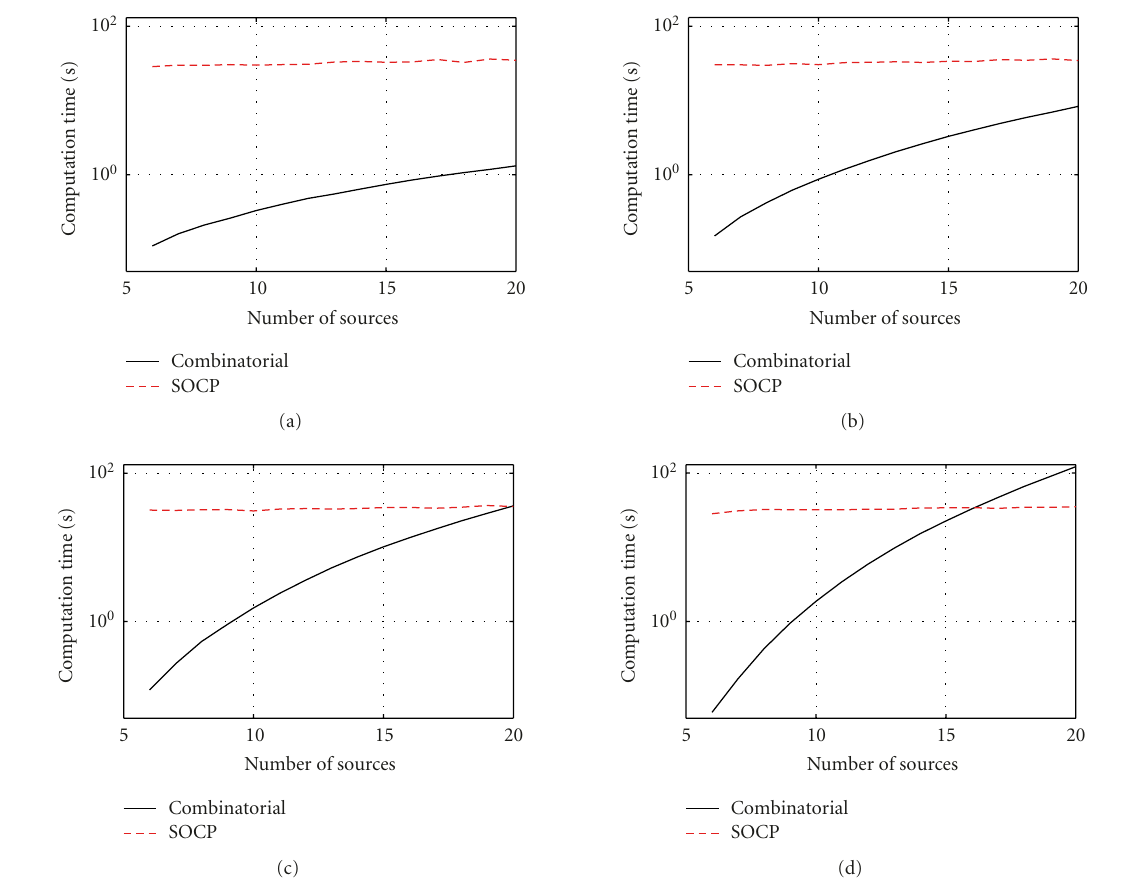
Figure 8: Comparison of computational complexity: (a) 2 mixtures, (b) 3 mixtures, (c) 4 mixtures, and (d) 5